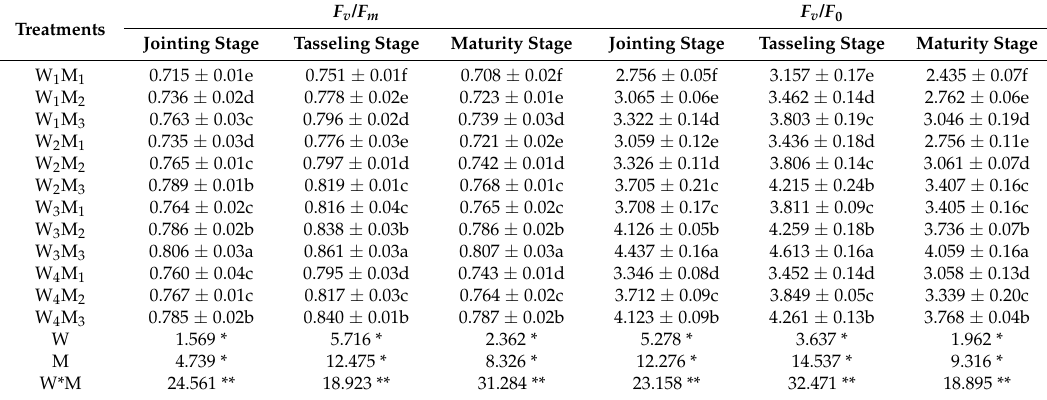
Table 4. Effect of irrigation amount on F v / F m and F v / F 0 of degradable film-covered drip-irrigated